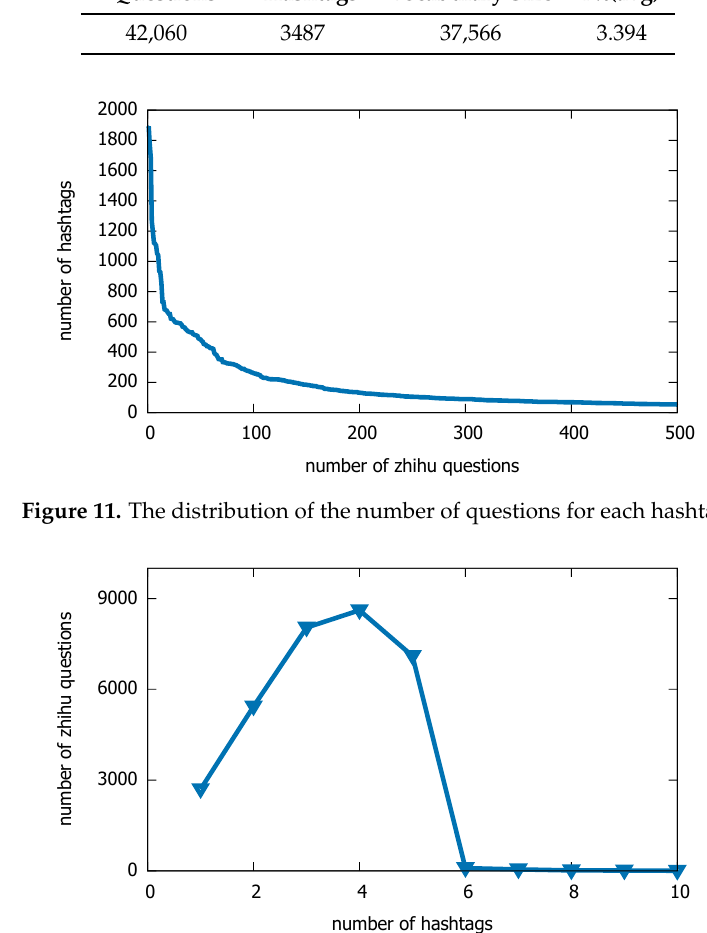
Figure 12. The distribution of the number of hashtags for each